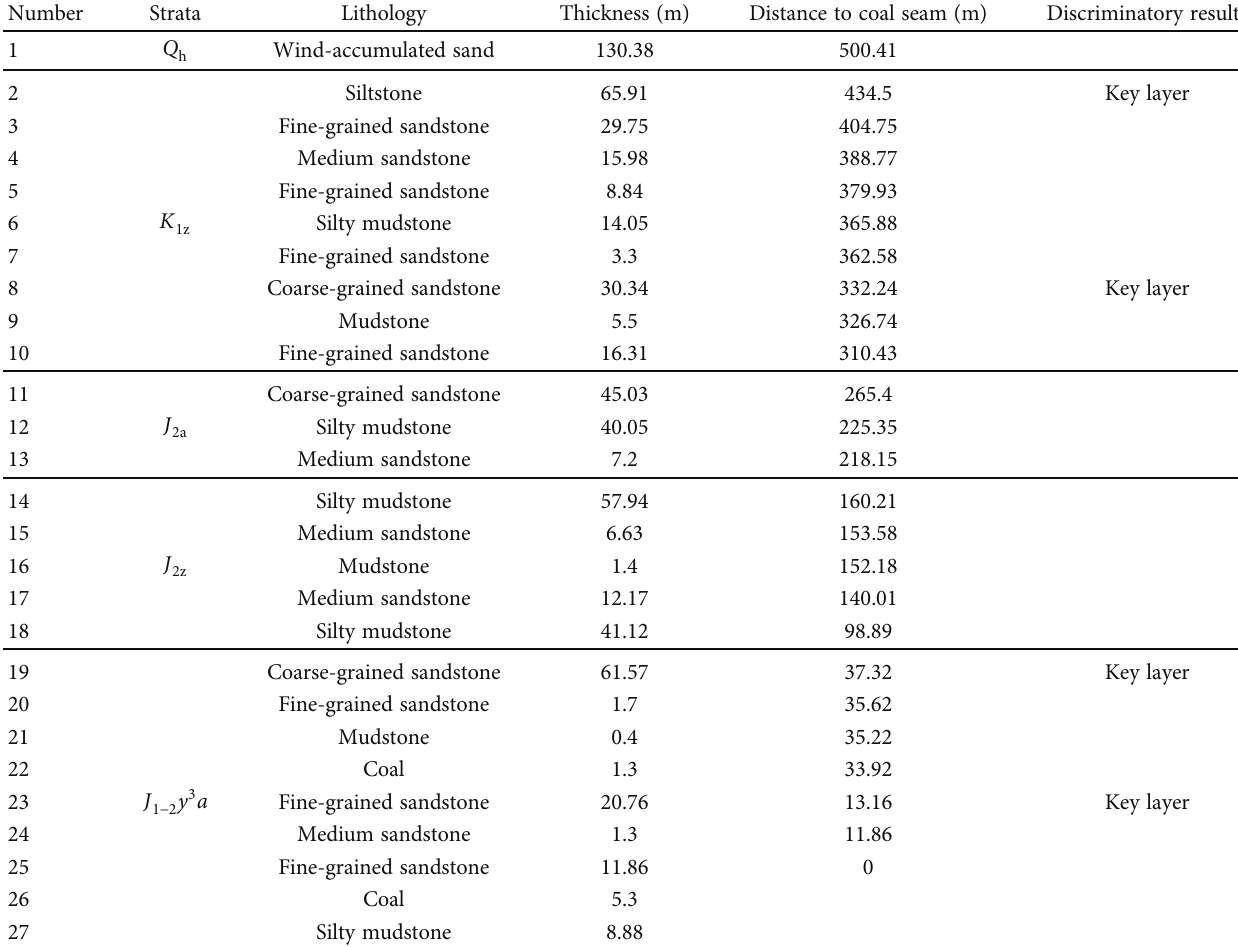
Table 1: Borehole B22 key layer discrimination results.